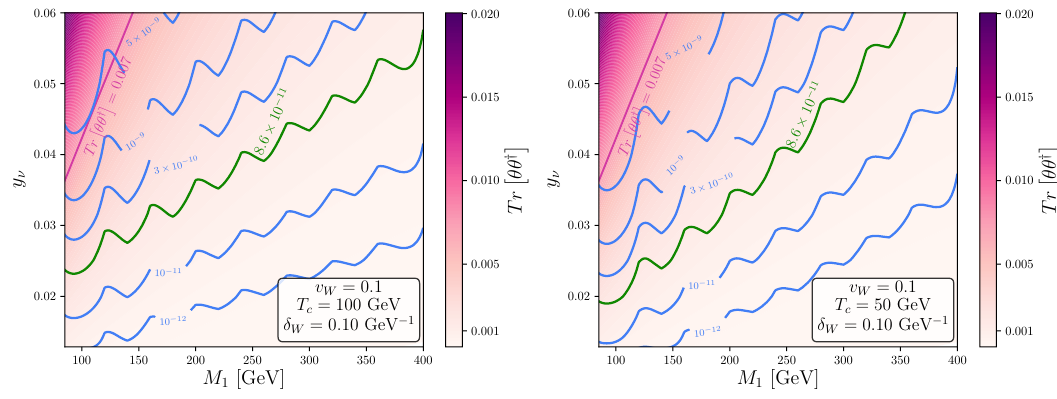
Figure 9 . Resulting baryon asymmetry as a function of the Yukawa coupling y heavy neutrino mass M 1 in the (cid:13)avoured scenario for T c = 100 GeV (left panel) and T c = 50 GeV (right panel). The masses of the other two heavy neutrinos are M 2 = M 1 + 10 GeV and M 3 = M 2 + 10 GeV. Along the green line the observed BAU is reproduced. The value of Tr represented by the color bar legend, while the bound for this quantity is represented with the magenta line for Tr (cid:18)(cid:18) y = 0 : 007 (cid:2) (cid:3)